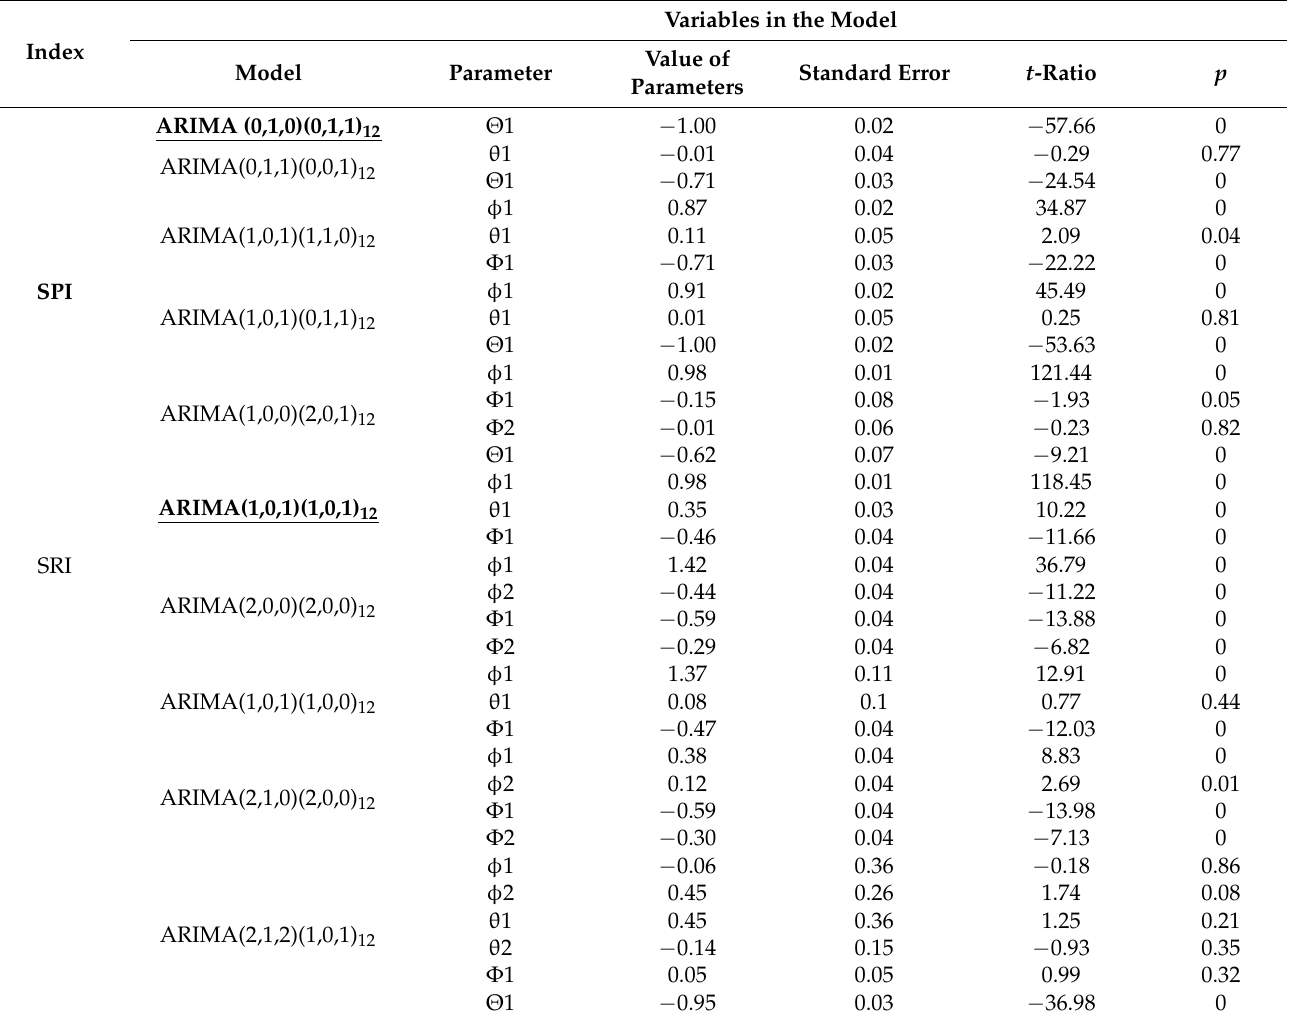
Table 3. Summary of the statistical analysis of model parameters.